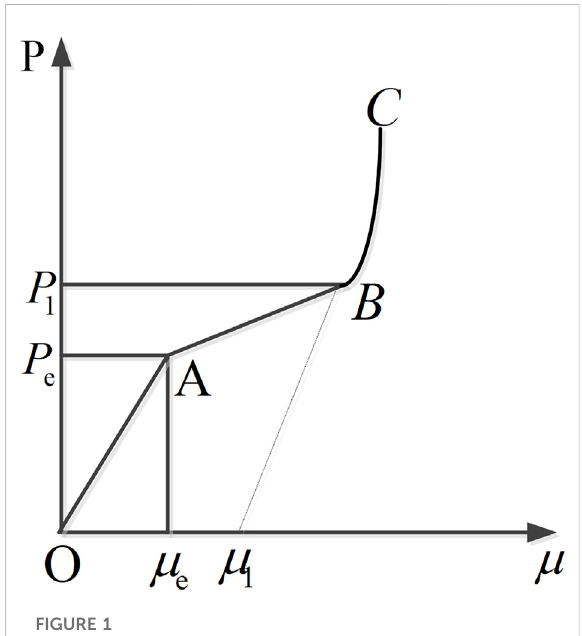
FIGURE 1 Concrete pure water stress and volume strain